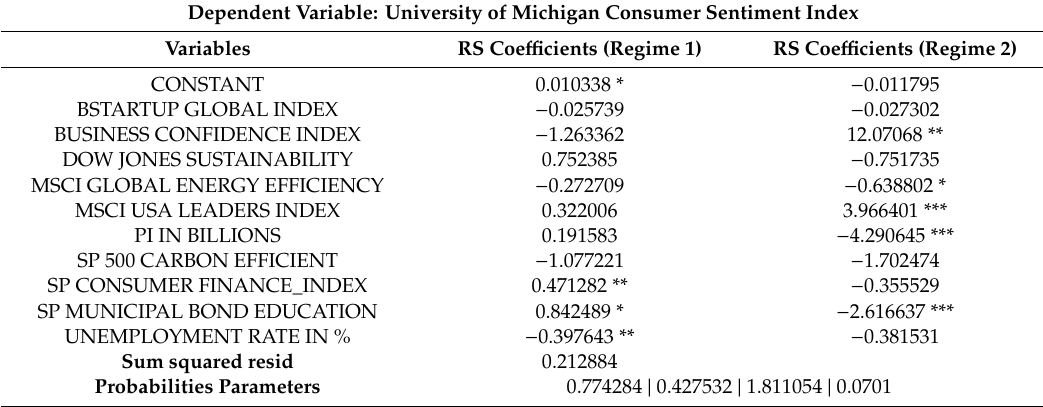
Table 4. Results of regression analysis—Regime-Switching